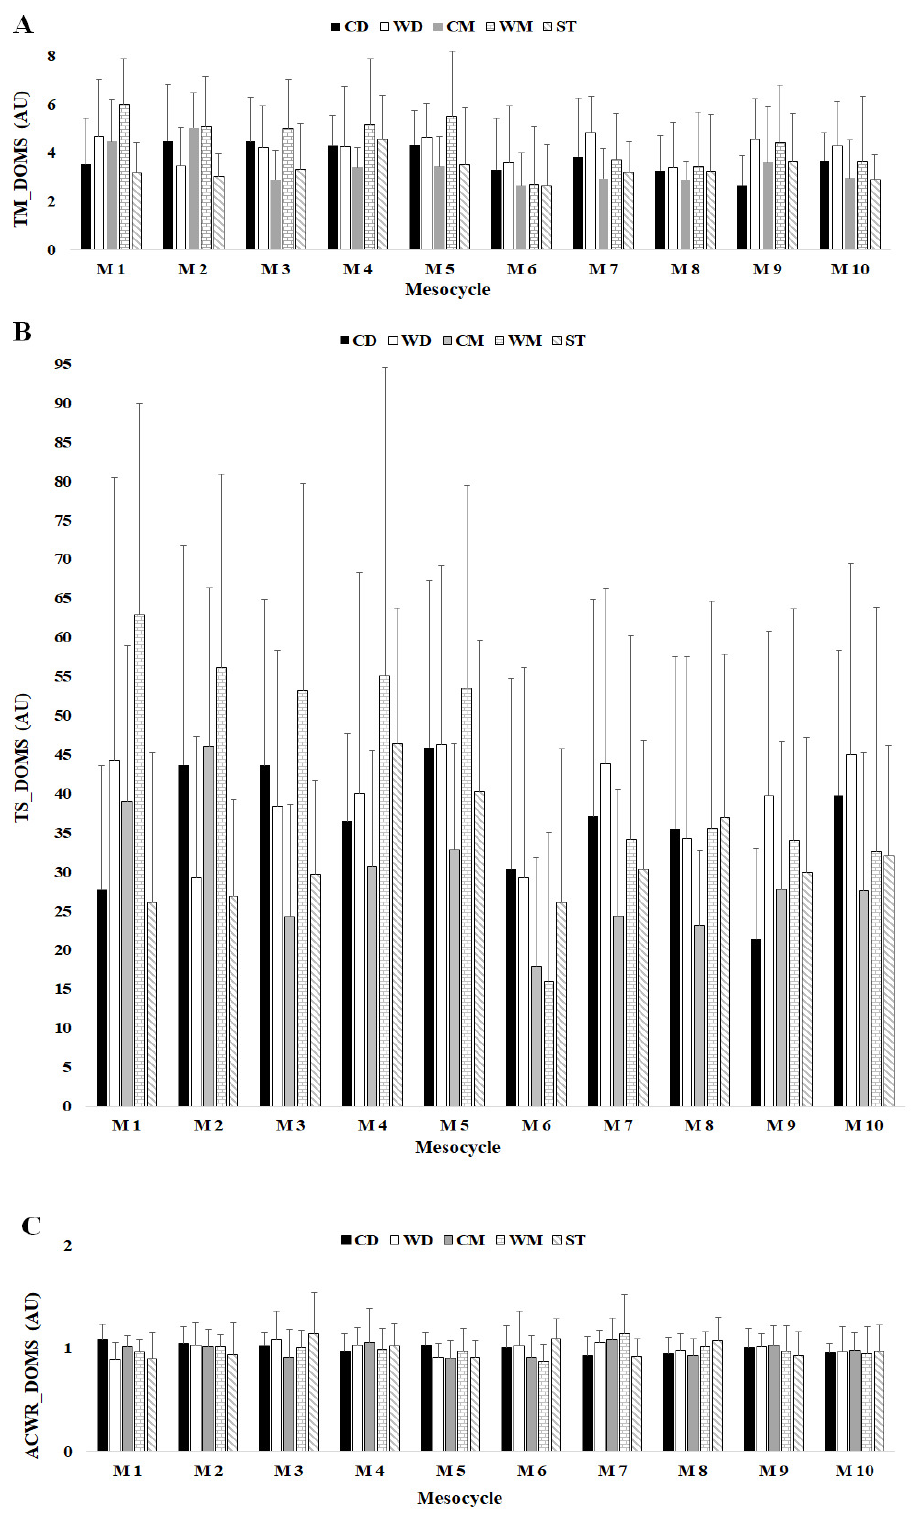
Fig. 5. Training Monotony (TM), Training Strain (TS) and Acute: Chronic Workload Ratio (ACWR) variations calculated through DOMS category across 10 mesocycles (M1-10) for player positions. (A) TM. (B) TS. (C) ACWR. CD, central defenders; WD, wide defenders; CM, central midfielders; WM, wide midfielders; ST,